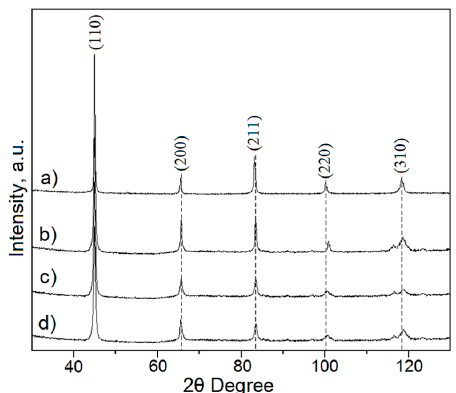
Figure 2. XRD patterns of ( a ) gas-atomized Ti-45Nb powder; and Ti-45Nb samples produced by ( b ) green compaction (50 kN) and sintering at 1000 °C followed by water quenching; ( c ) hot-pressing at 600 °C with 50 kN; and ( d ) hot-pressing at 600 °C with 50 kN followed by sintering at 1000 °C and water quenching, where only peaks corresponding to the β phase are observed.